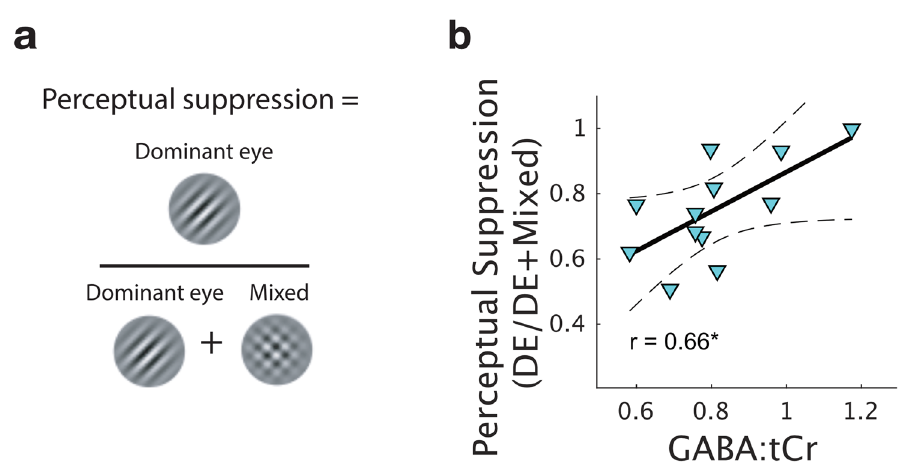
Figure 5. (a) To compare with previous data, we calculated an alternative measure of binocular rivalry dynamics, the ‘perceptual suppression’ rate (Robertson et al. 17 ). (b) Resting GABA:tCr levels was correlated with binocular rivalry perceptual suppression [dominant eye/(dominant eye + mixed percept)]. r = Pearson’s linear correlation co-efficient. * p < 0.05, uncorrected. Solid line represents best fitting linear model, hatched lines represent 95% confidence interval of the regression